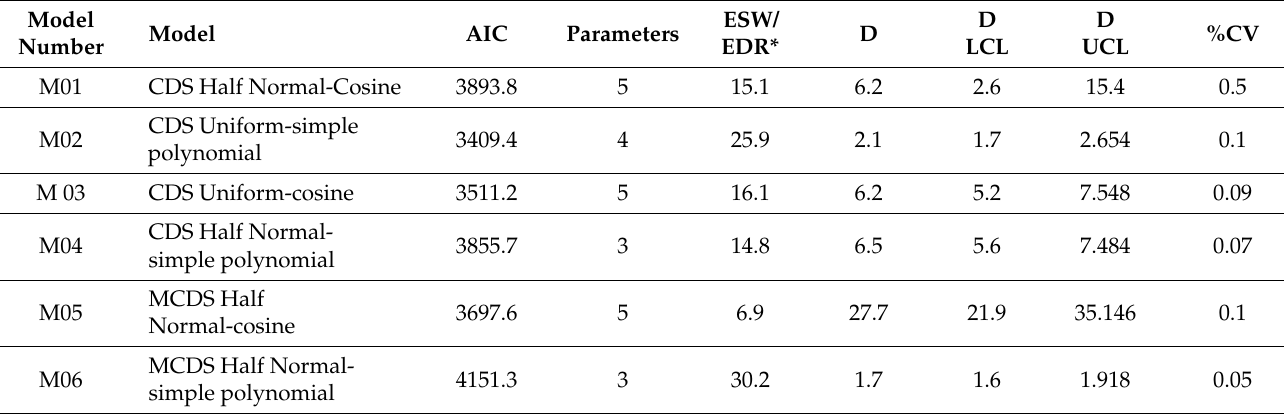
Table 4. Model selection based on estimates of AIC and density for the habitat of Koklas pheasant in the study